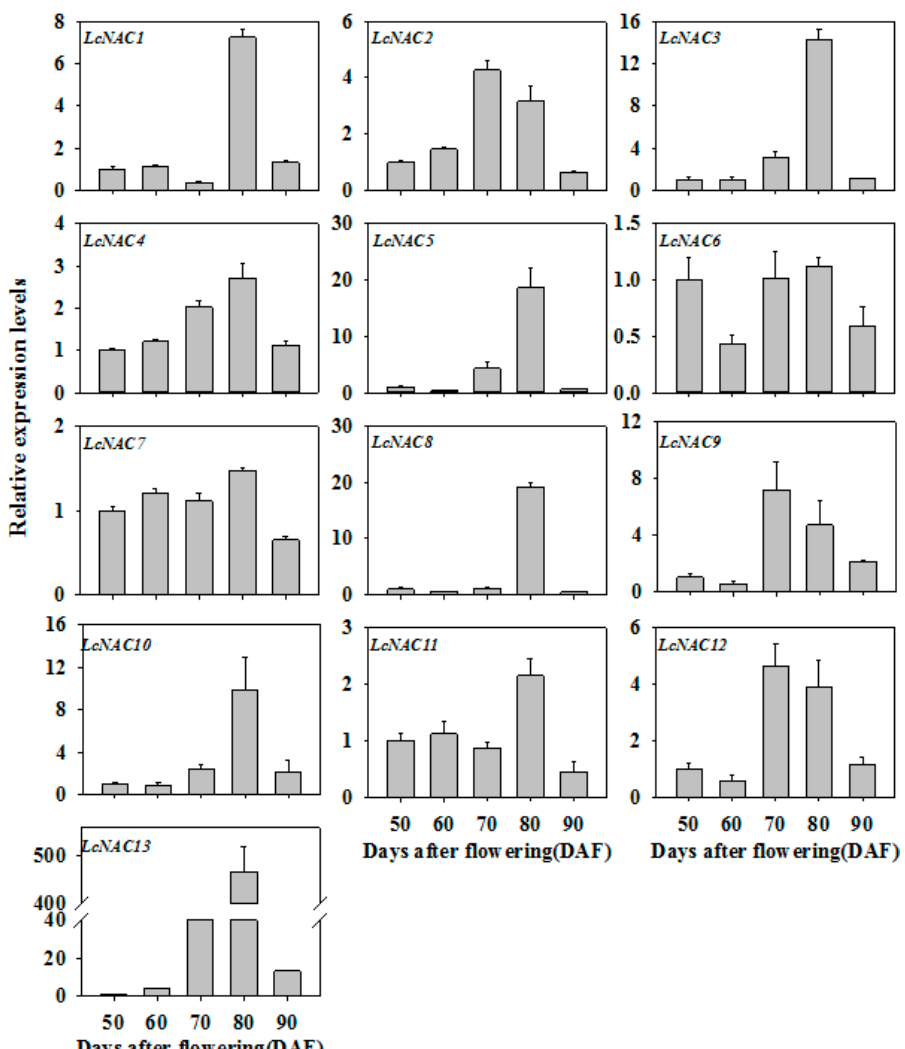
Figure 2. Expression of 13 LcNAC genes in litchi fruit pericarp during ripening. The expression levels are expressed as a ratio relative to that at 50 DAF, which was set as 1. LcACT1 was used as an internal control. Each value represents the mean + standard error of three replicates.